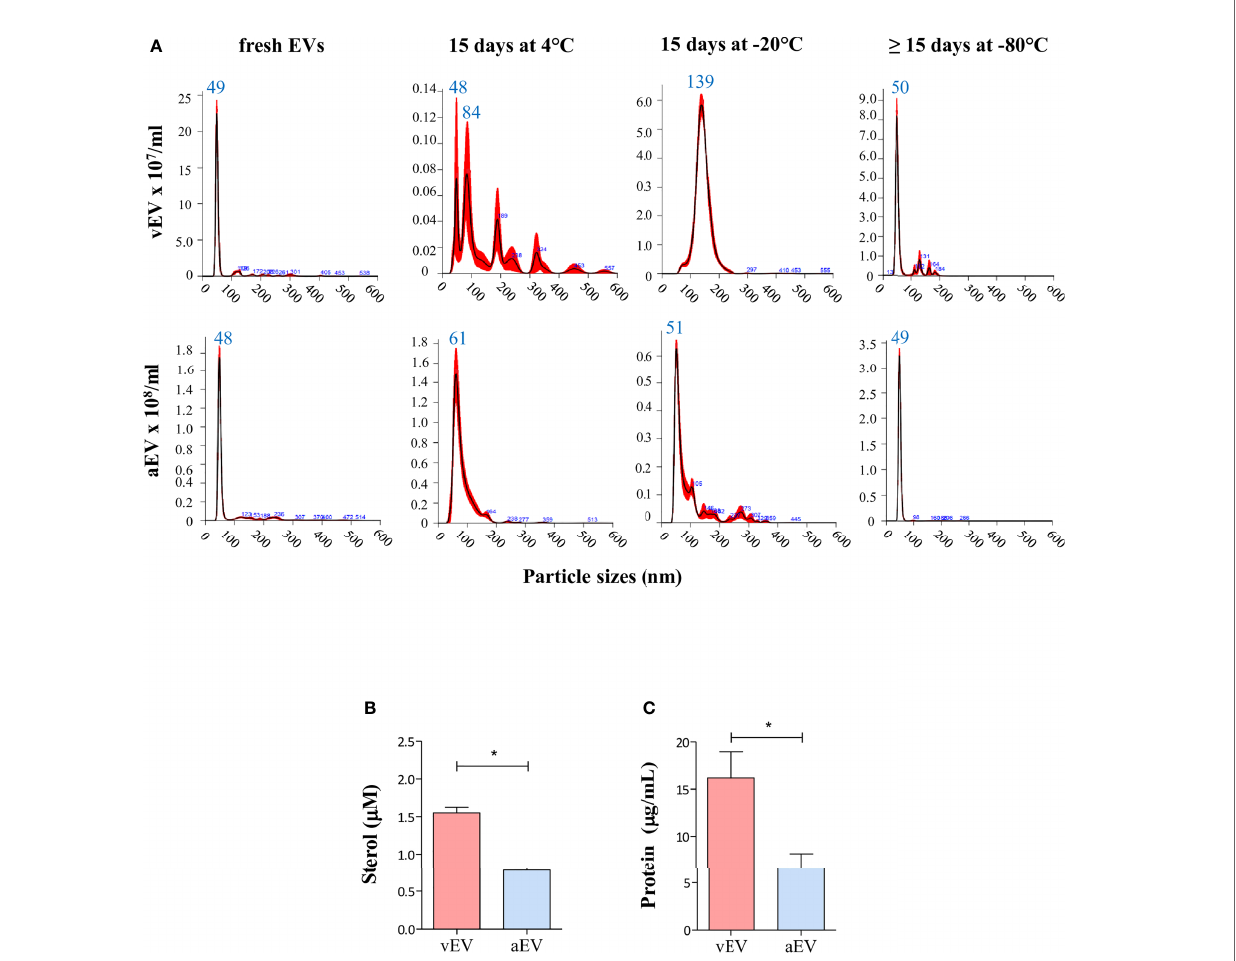
FIGURE 2 | Comparative features of aEVs and vEVs. (A) NTA analysis of EVs isolated from the yeast form of P. brasiliensis vPb18 (vEVs, upper graphics) and its attenuated form aPb18 (aEVs, bottom graphics) cultivated in Ham/glc agar plates. The columns show the plots for the EV preparations assayed fresh (or up to 24 h at 4°C), after 15 days at 4°C, after 15 days at − 20°C, and after 15 days or more at − 80°C, as indicated. (B, C) Estimated (B) sterol (mM) and (C) protein (mg/ml) concentrations per 3 × 10 9 EV particles. Statistically signi fi cant results are indicated as * p <